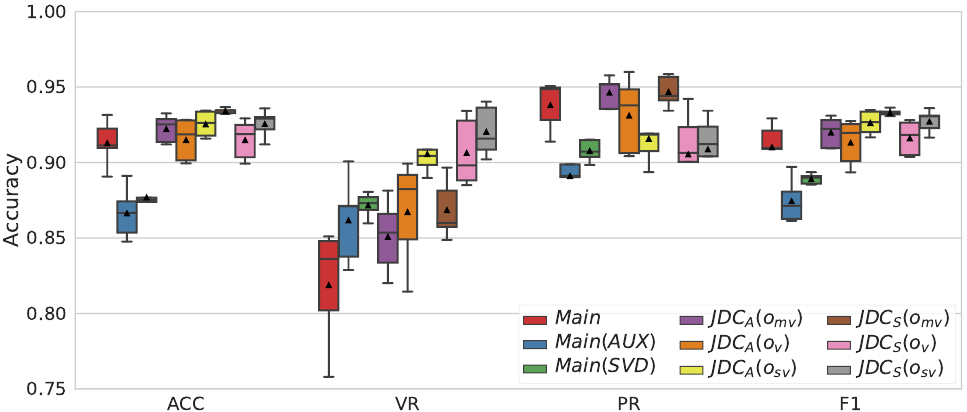
Figure 4. Performance of singing voice detection for different evaluation metrics. “ACC” indicates the overall accuracy of voice detection. “PR” and “F1” indicate precision and F1 score,